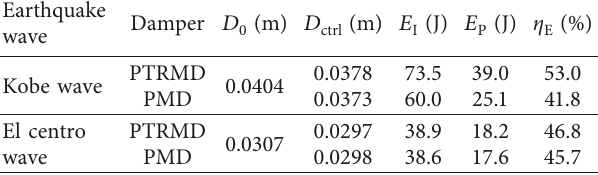
D D � displacement responses of the main structure with and ctrl and 0 without damper.